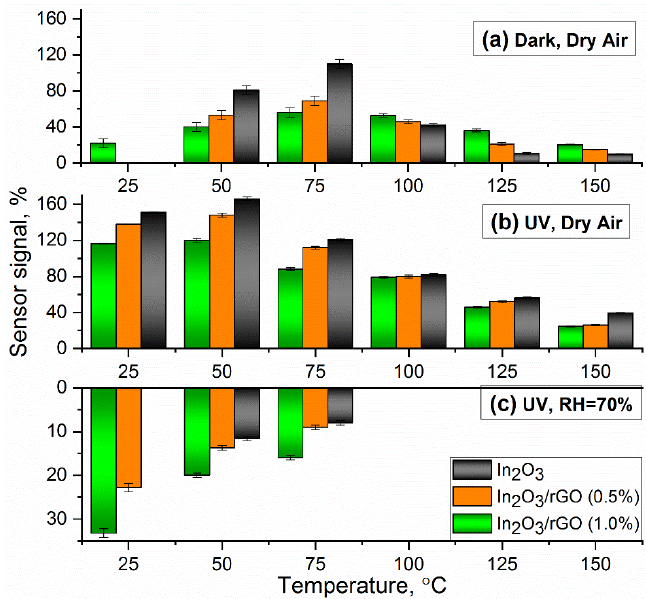
Figure 8. Temperature dependence of the sensor signal of the materials upon the detection of 20 ppm NH 3 under various experimental conditions: ( a ) under dark conditions with dry air; ( b ) under UV illumination with dry air; and ( c ) under UV illumination with a relative humidity of 70% (RH = 70%). In the case of UV illumination (Figure 6b), a decrease in resistance of all sensors was observed, thereby achieving a reproducible response to NH 3 , even at room temperature.